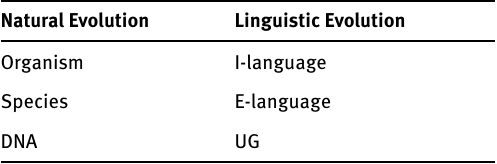
Table 3: Correlation between natural and linguistic evolution (second version)